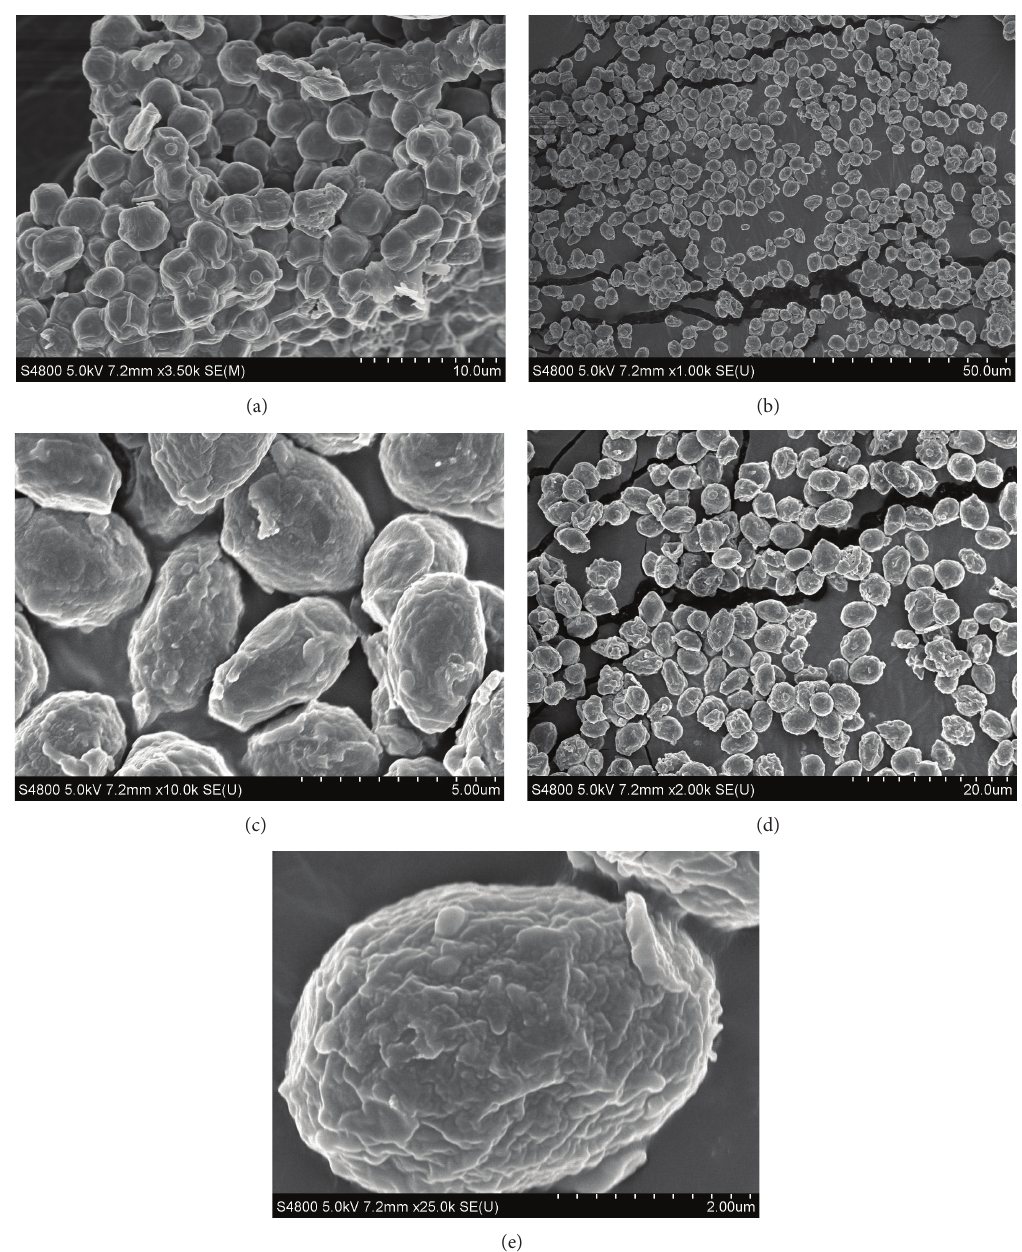
Figure 1: FE-SEM images of (a) yeast and (b, c, d, and e) HPW@yeast microspheres observed under different